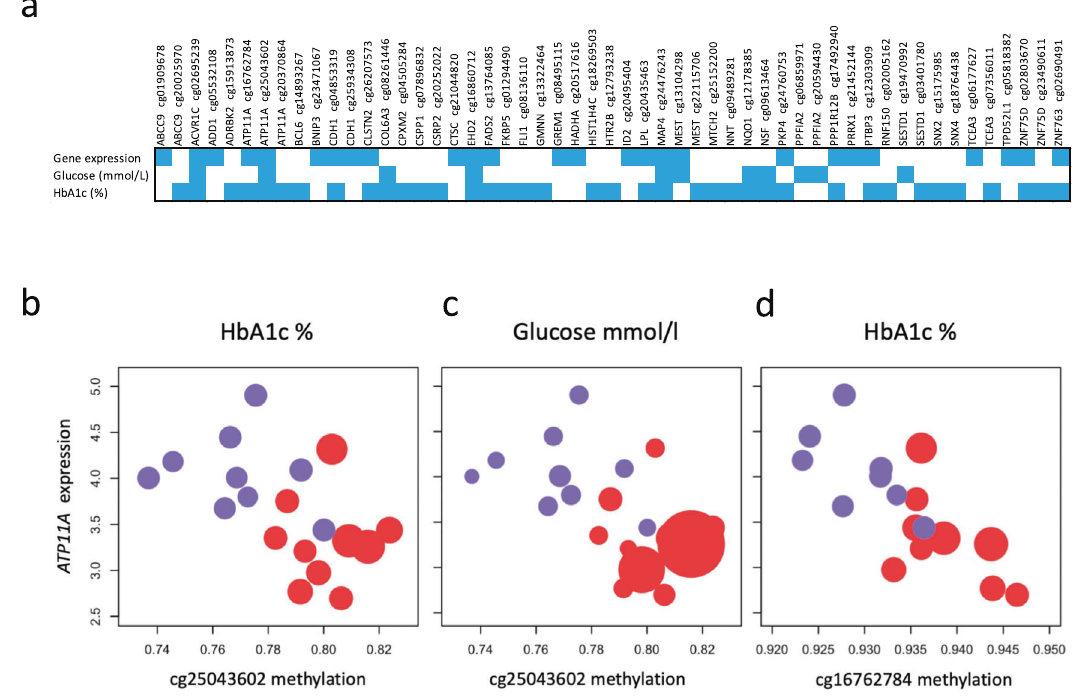
Fig. 3 Correlations between differentially methylated CpGs, gene expression, and T2D-related traits. a Plot displaying only the DMCs with signi fi cant Pearson correlation ( p value <0.05) between DNA methylation levels and corresponding gene expression, fasting glucose, and HbA1c levels; blue squares indicate those with signi fi cant p values. b – d ATP11A : Pearson ’ s correlation for two of its representative DMCs with expression levels. Red dots represent OD patients, purple represents OND; the size of the dot depends on the value of each T2D-related trait. X axis: β -methylation; Y axis: ATP11A expression levels. b cg25043602- ATP11A expression: r = – 0.533, p = 0.037; cg25043602-HbA1c: r = 0.686, p = 0.002. c cg25043602-Glucose: r = 0.539, p = 0.031; d cg16762784- ATP11A expression: r = − 0.766, p = 0.003; cg16762784-HbA1c: r = 0.548, p = 0.038.